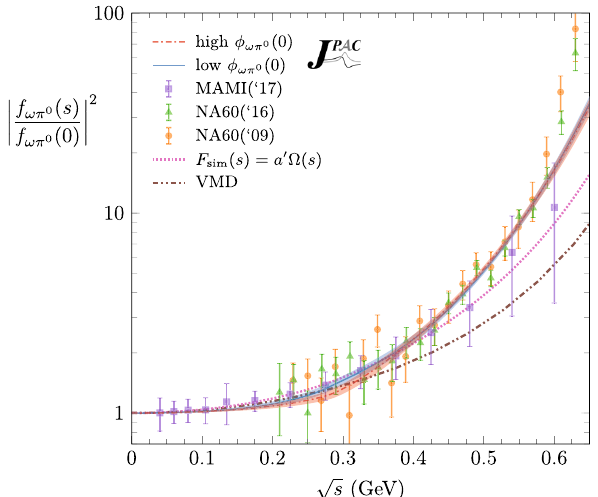
Fig. 7 Normalized ωπ 0 TFF, | f ωπ 0 ( s )/ f ωπ 0 ( 0 ) | 2 . The data are taken fromRefs.[36–38].Thelines,andtheirassociatederrorbands,represent ourtwodifferentsolutions,whichoverlapalmostcompletelyinthe ωπ 0 invariant mass range shown. The case shown here is that corresponding to the “3 par.” fit. The curves for the “2 par.” case are very similar. For comparison, we also show the Vector Meson Dominance (dot-dot- dashed brown) prediction, and that of the model without KT equations (dotted pink curve) discussed in Sect. 3.3, cf. Eqs.